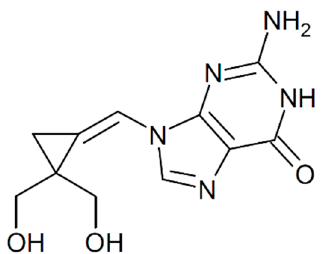
Figure 1. The chemical structure of filociclovir (FCV).